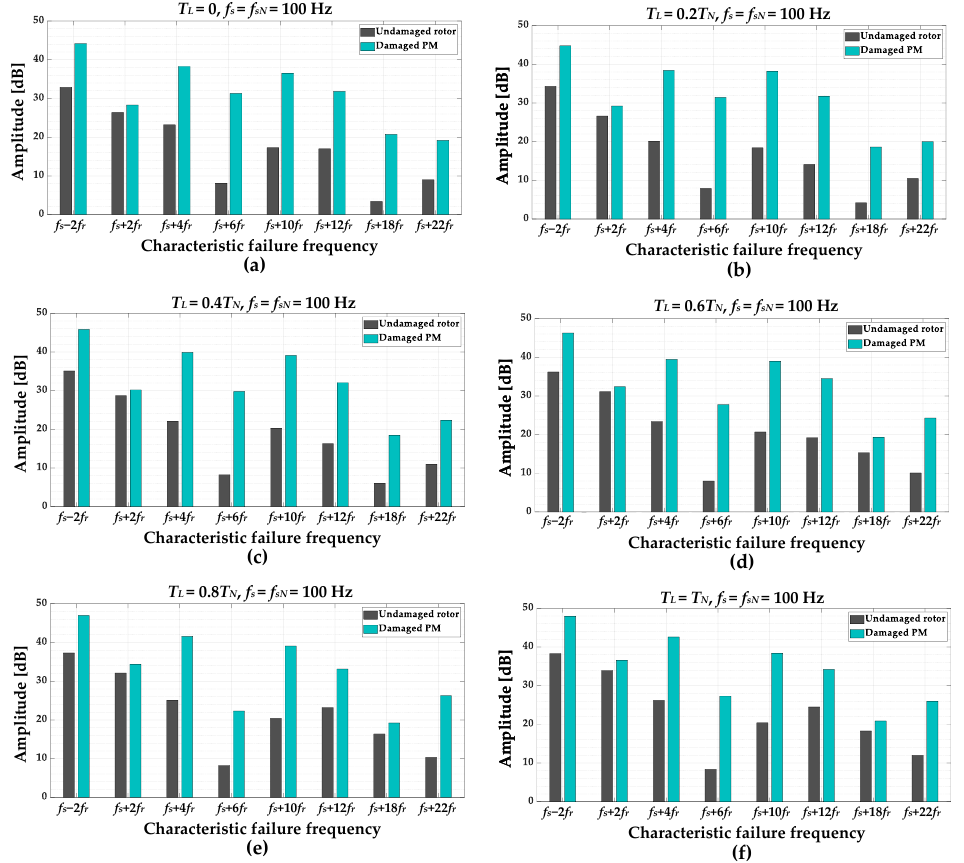
Figure 9. The impact of the damaged PM (partial demagnetization) of the PMSM rotor and T L on the amplitude levels of the frequency component in the stator phase current STFT spectrogram ( a ) T L = 0, ( b ) T L = 0.2 T N , ( c ) T L = 0.4 T N , ( d ) T L = 0.6 T N , ( e ) T L = 0.8 T N , (f) T L = T N .